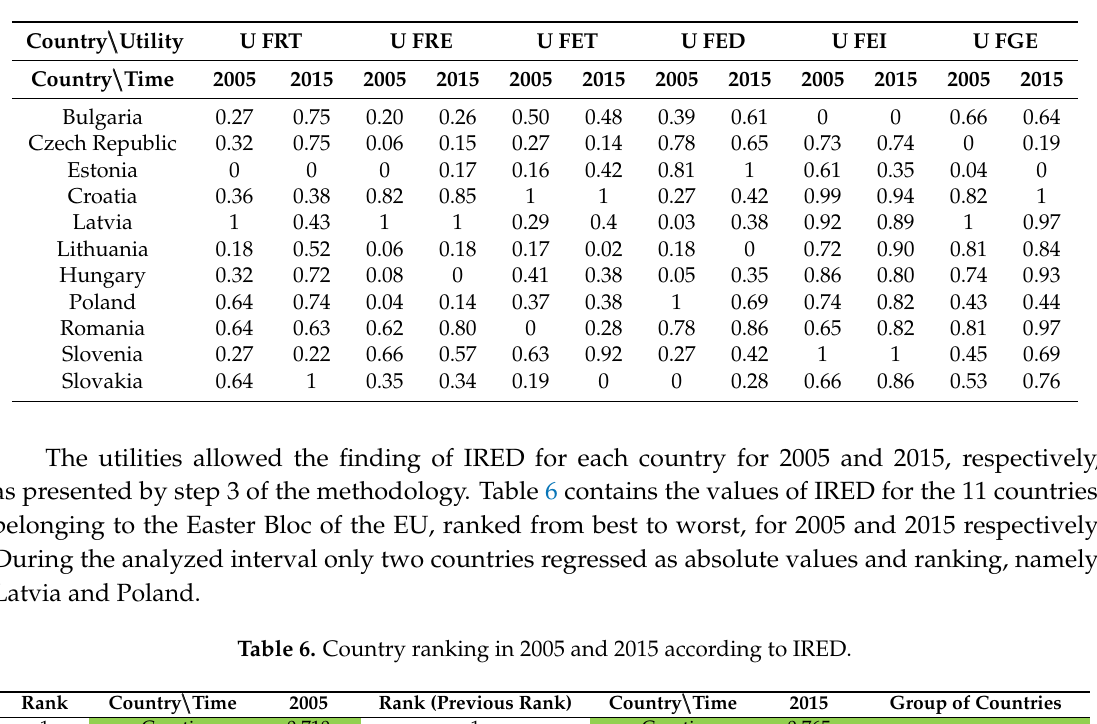
Table 5. Utilities of the factors of renewable energy development architecture.